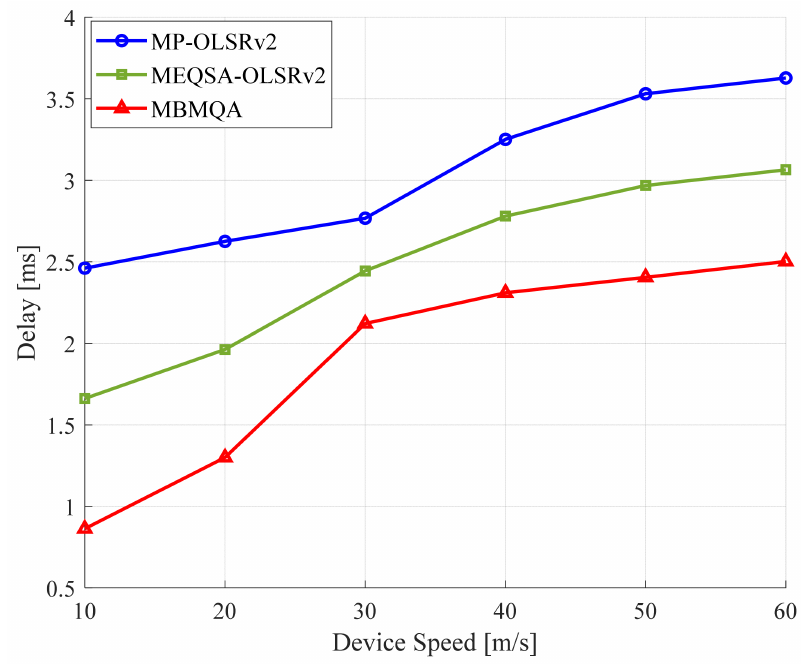
Figure 5. End-to-end delay for various device